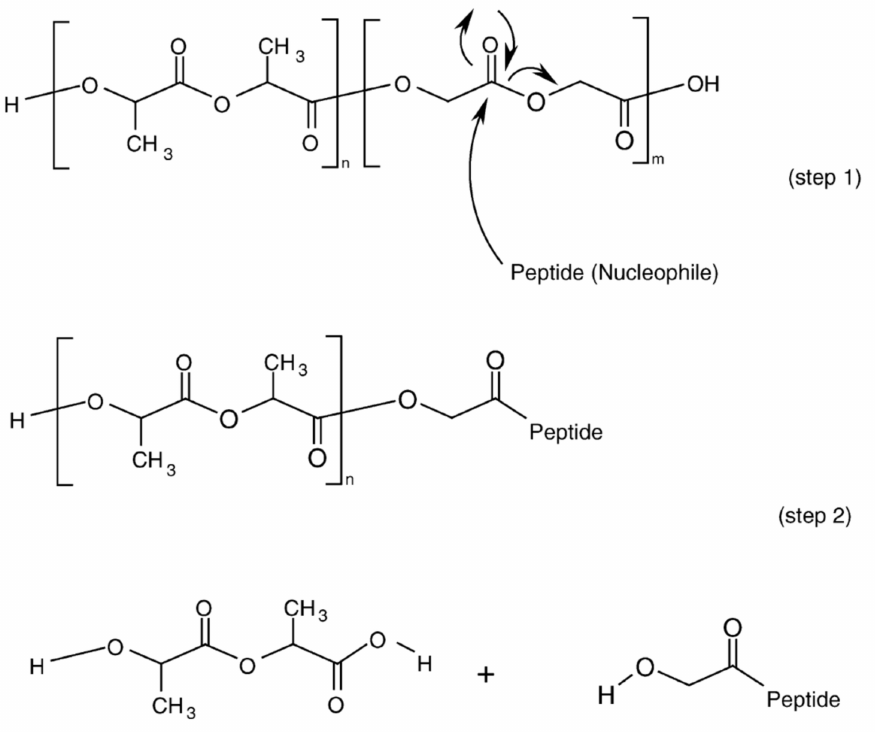
Figure 6. Proposed mechanism of acylation reaction of peptides incorporated into PLGA microparti- cles. Reprinted with permission from ref. [36]. Copyright 2005